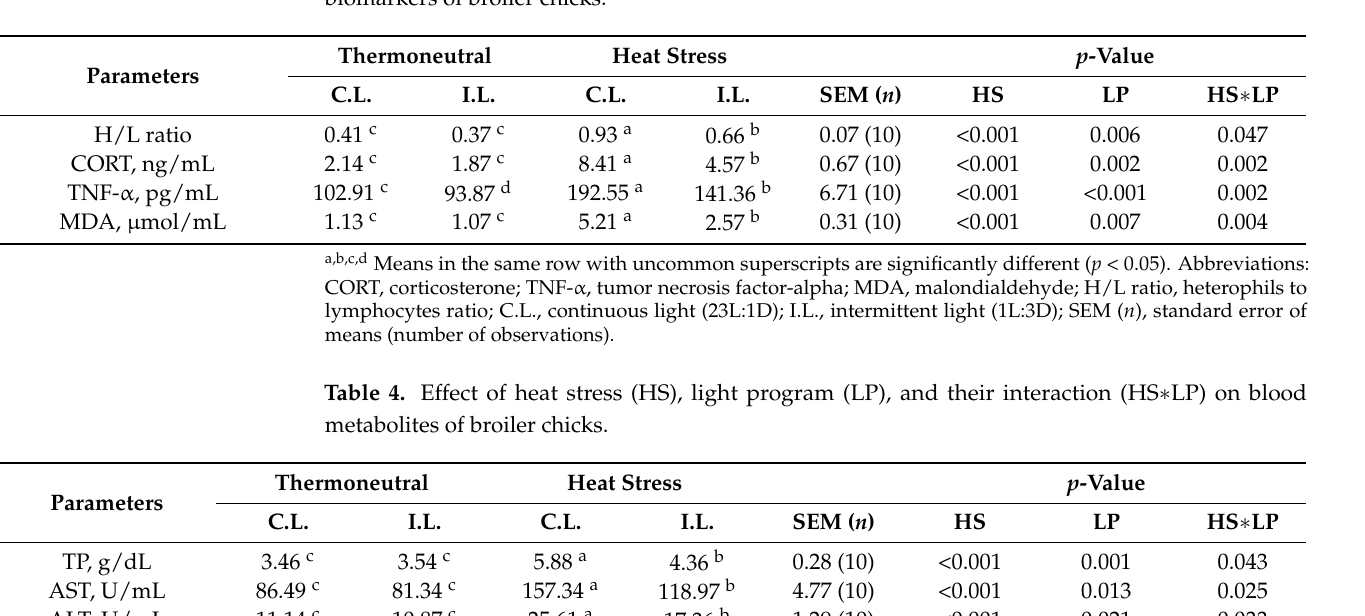
Table 3. Effect of heat stress (HS), light program (LP) and their interaction (HS ∗ LP) on stress biomarkers of broiler chicks.